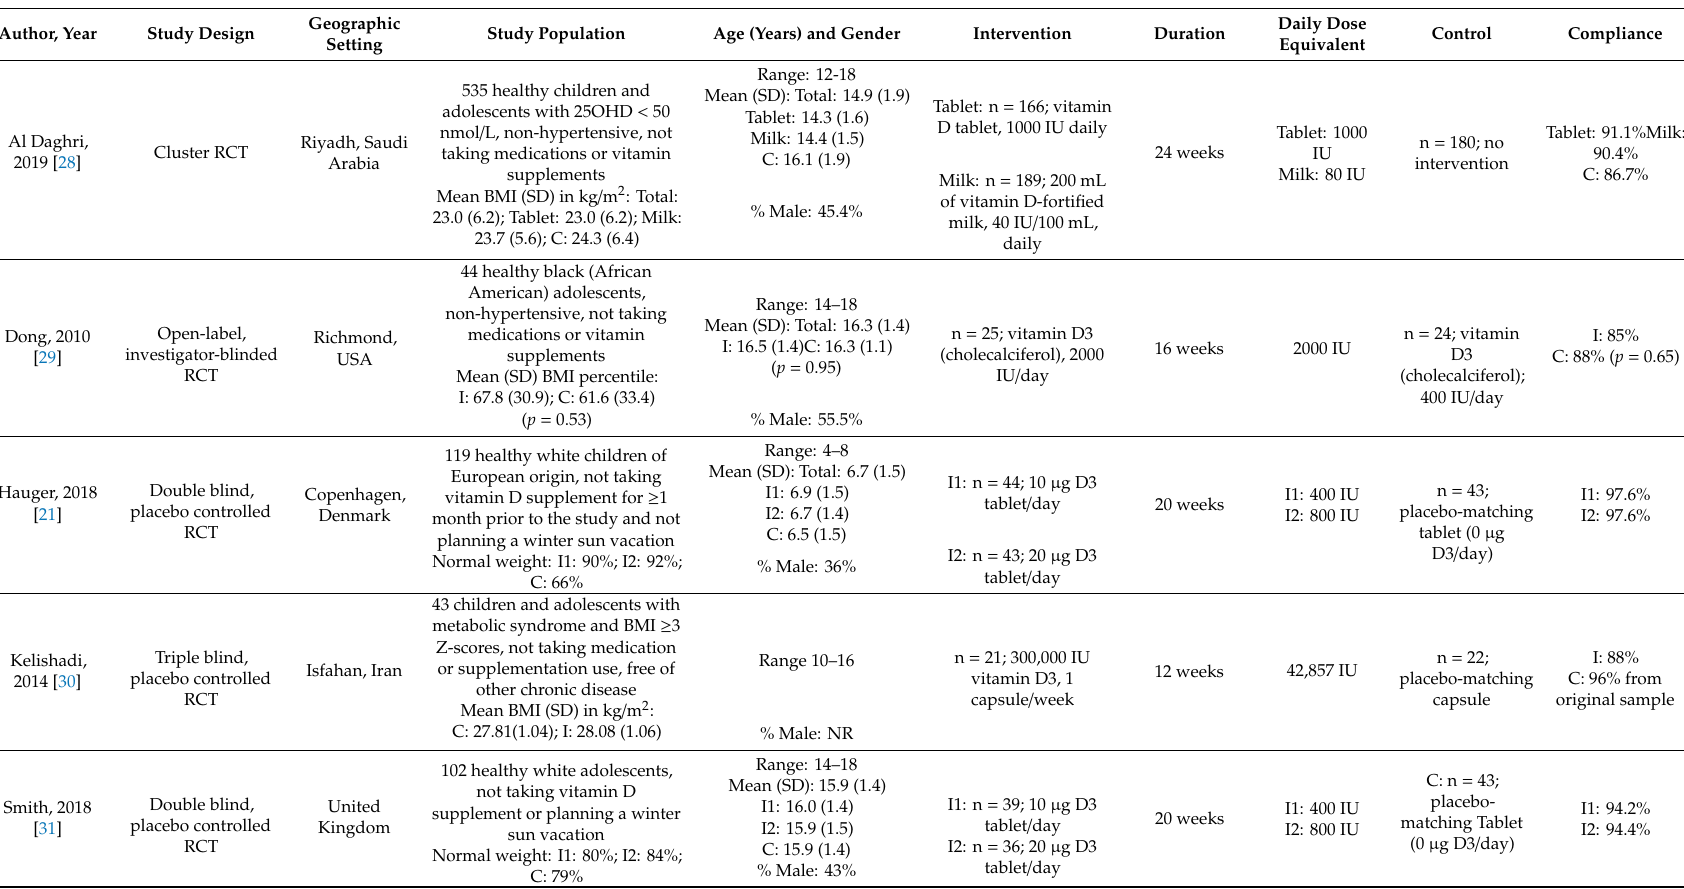
Table 2. Characteristics of